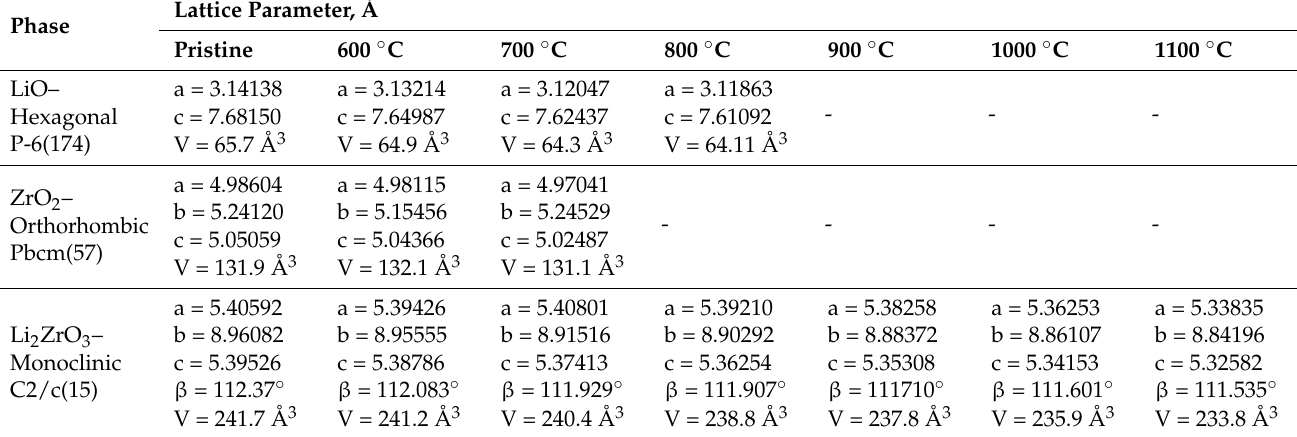
Table 1. Structural parameter data.